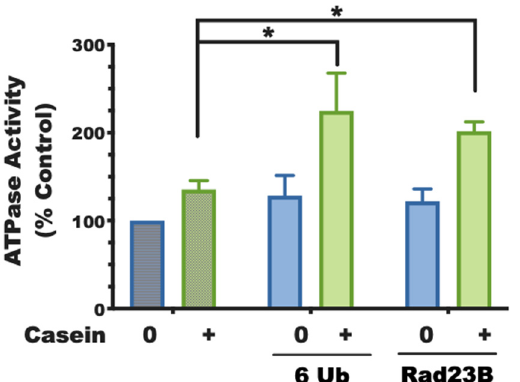
Figure 2. Activation of the 26S ATPases requires two signals. The basal rate of ATP hydrolysis by rabbit muscle proteasomes can be stimulated by a ubiquitinated substrate provided it contains both a ubiquitin chain (e.g., here, a linear hexa-ubiquitin, 6 Ub) and a protein with a loosely folded domain (e.g., casein). Normally, these two features are covalently linked in a ubiquitinated substrate but, as shown here, they can activate if on separate molecules. Additionally, isolated UBL domains or a full-length UBL protein (e.g., Rad23B) can replace ubiquitin chains in activating the 26S ATPases (adapted from [8]). (Mean of three experiments ± SEM; * denotes p < 0.05).